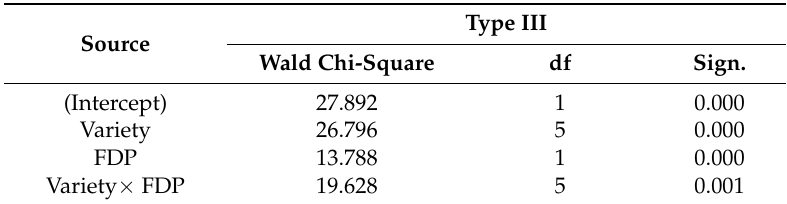
Table 2. Output of the generalized linear model (GLM) analysis. df: degree of freedom, Sign.: significance, FDP: Flavescence dorée phytoplasma.